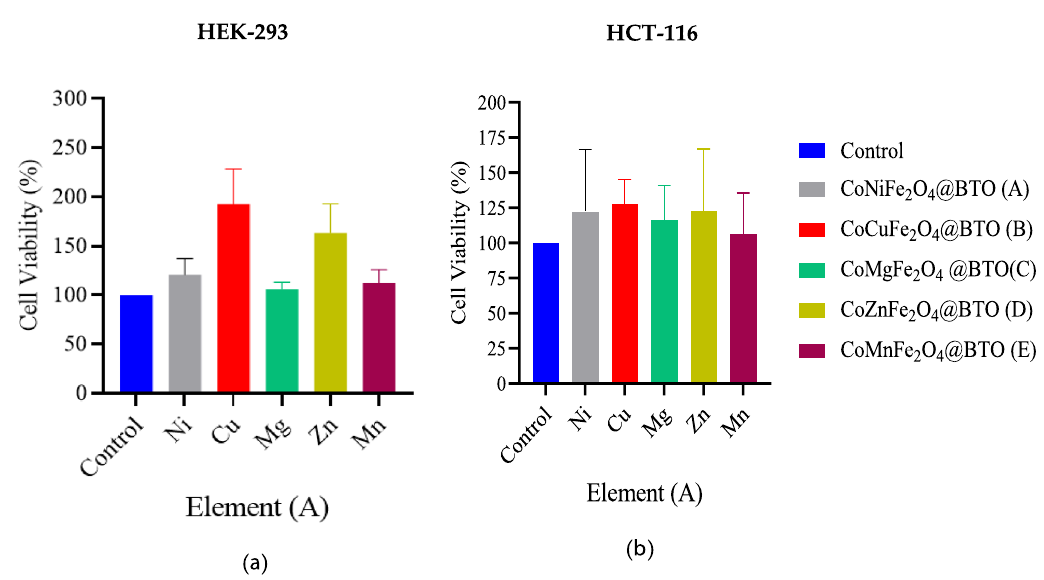
Figure 7. The average cell viability of ( a ) HEK-293 and ( b ) HCT-116 cell lines by MTT assay. Cells were treated with the following conditions